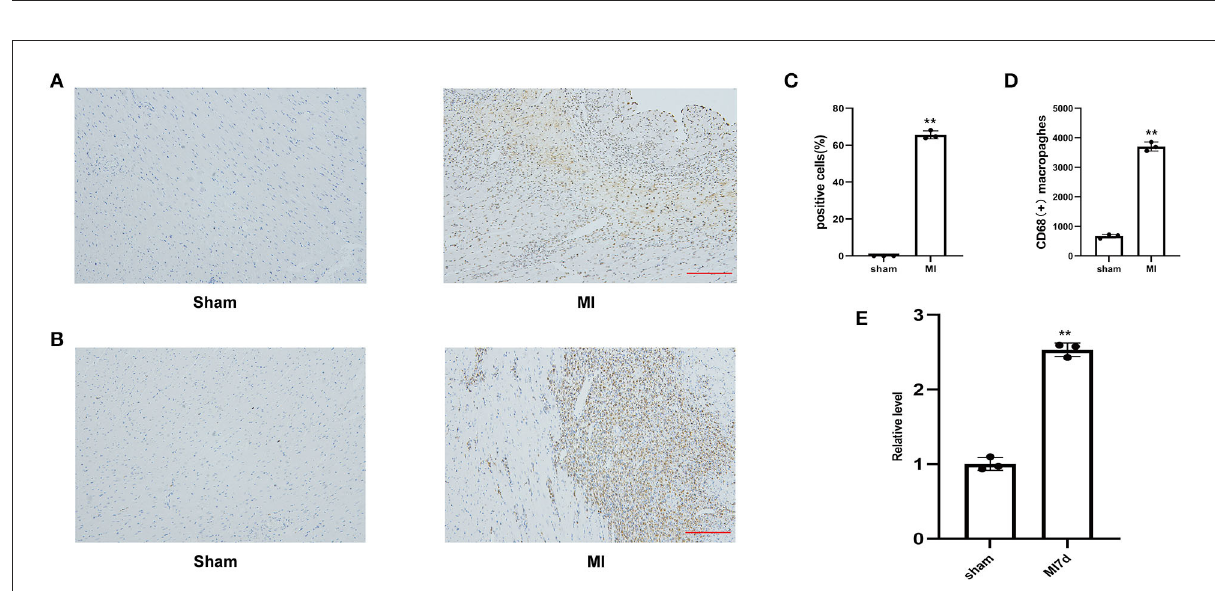
FIGURE4 (A) Representative image of TUNEL staining of heart tissues, the amount of which reflects the degree of myocardial apoptosis. The apoptotic cells were stained brown and the neuron was stained blue (100HFP), bar = 100 µ m. (B) Representative image of immunohistochemical staining for macrophage marker CD68 (brown) and nuclei (blue) (100HFP), bar = 100 µ m. (C) The percentage of apoptotic cells at the infarcted border zone. **A P- value of < 0.01 compared with the sham group. (D) Quantification of infiltrated macrophages at the infarcted border zone. **A P- value of < 0.01 compared with the sham group. (E) Comparison of lncRNA LOC100911717 expression between the sham and MI7d groups. n = 3 per group. **A P- value of < 0.01 compared with the sham group.